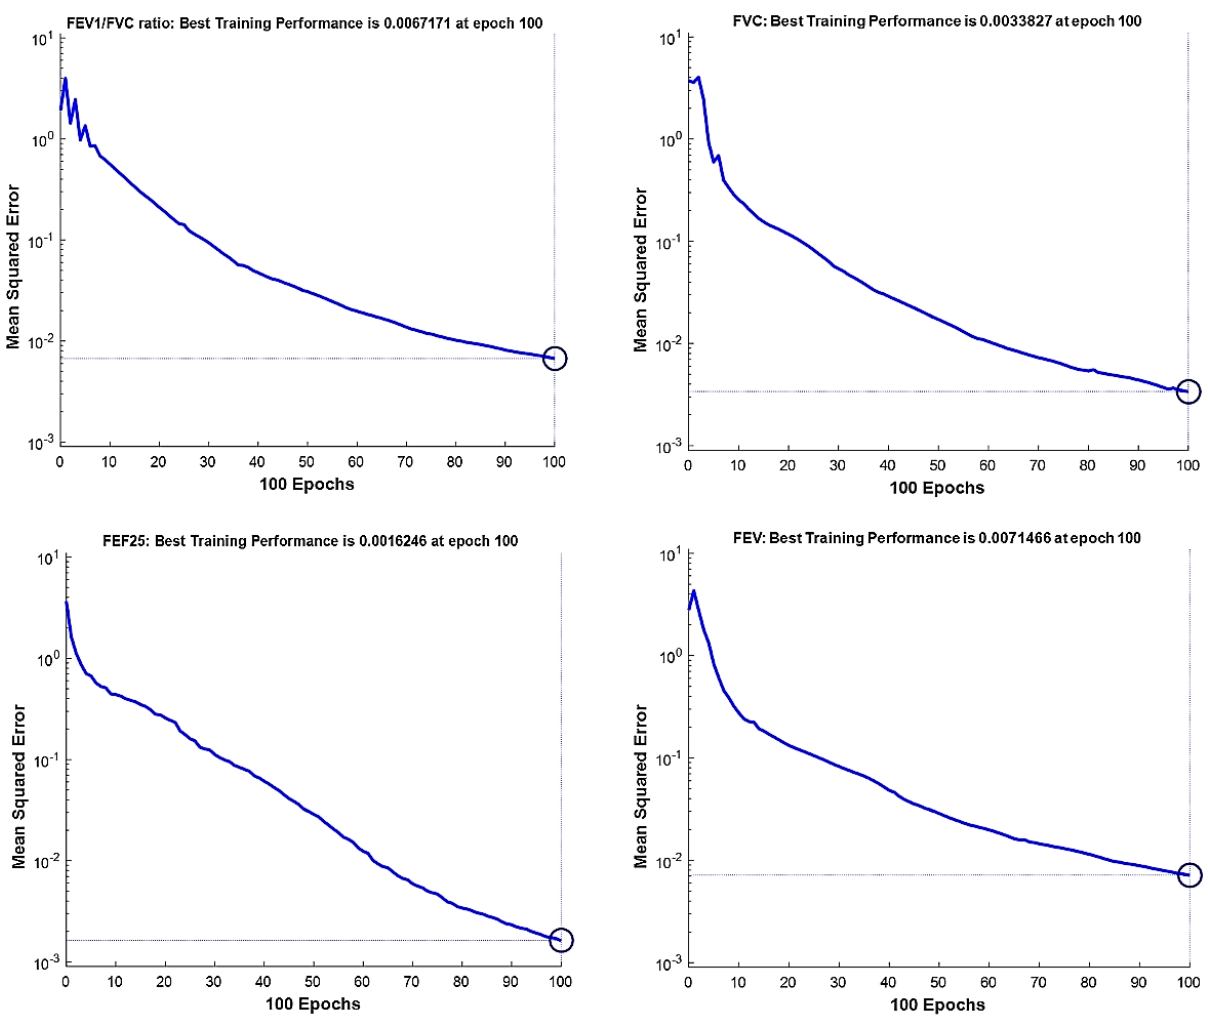
Figure 5. Training performance of the genetic algorithm–modified neural network for C sativus L supplement effects on the clinical factors: FEV 1 /FVC ratio (top left); FVC (top right); FEF-25 (forced expiratory flow, bottom left); FEV (forced expiratory volume, bottom